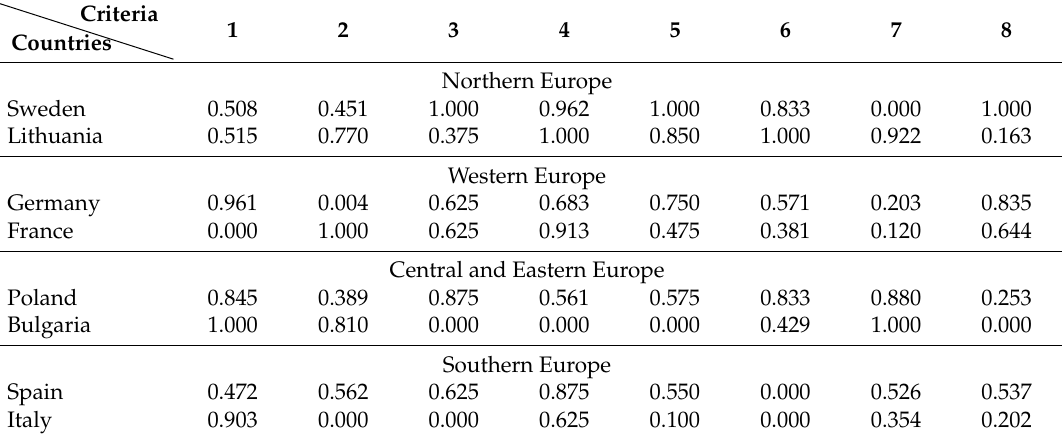
Table 9. The normalized decision matrix for the simple additive weighting (SAW)